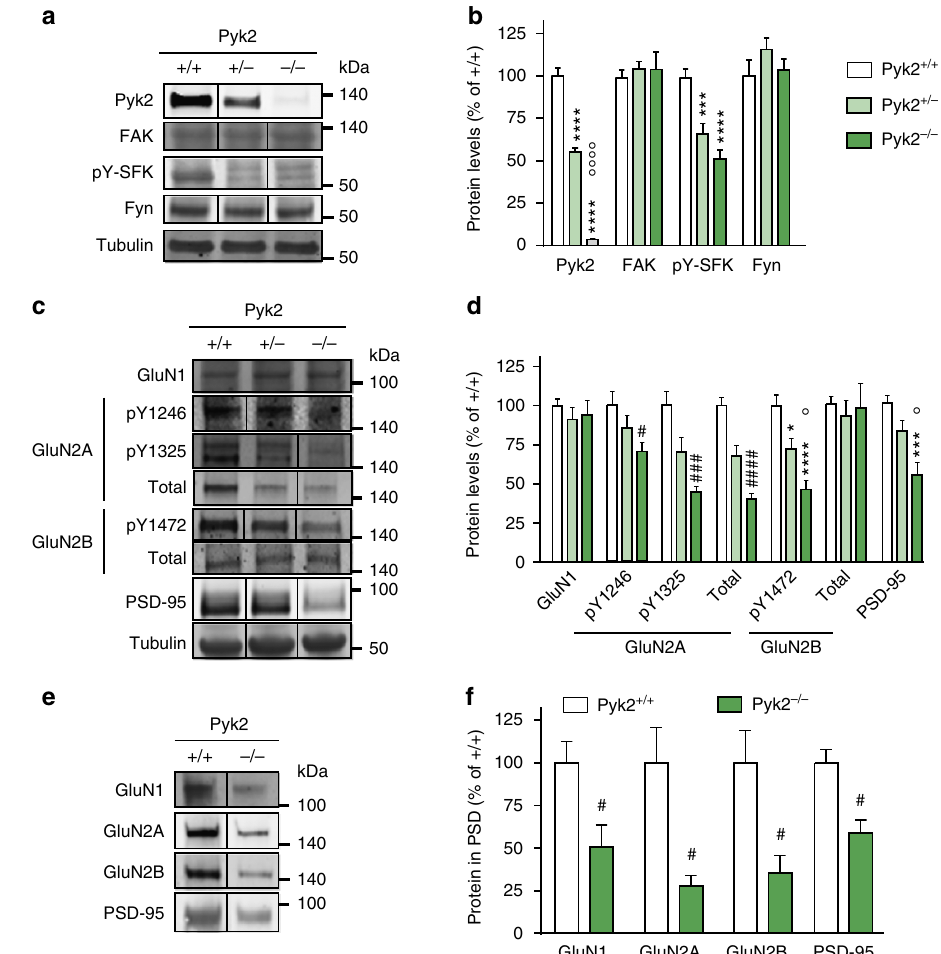
Figure 2 | Hippocampal proteins phosphorylation and levels in Pyk2-deficient mice. ( a ) Immunoblotting analysis of Pyk2, the related tyrosine kinase FAK, the active autophosphorylated form of Src-family kinases (pY-SFK, pTyr-420 in Fyn), Fyn and tubulin as a loading control in 3-month-old Pyk2 þ / þ , Pyk2 þ / (cid:2) and Pyk2 (cid:2) / (cid:2) littermates. ( b ) Densitometry quantification of results as in a . Data were normalized to tubulin for each sample and expressed as percentage of wild type. ( c ) NMDA receptors subunits phosphorylated residues, total levels and PSD-95 were analysed by immunoblotting. ( d ) Results as in c were quantified and analysed as indicated in b . In b and d , statistical analysis was done with one-way ANOVA and Holm-Sidak’s multiple comparisons test or Kruskal–Wallis and Dunn’s test depending on the normality of distribution (see Supplementary Table 1 for tests used, values and number of